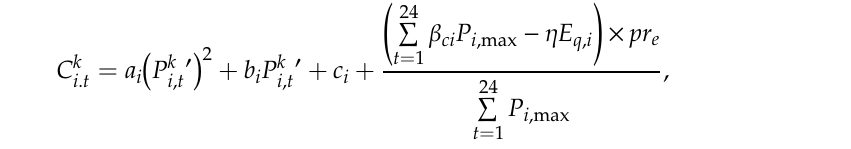
Figure 2. Multi-segment bid curve for conventional units (K = 5).